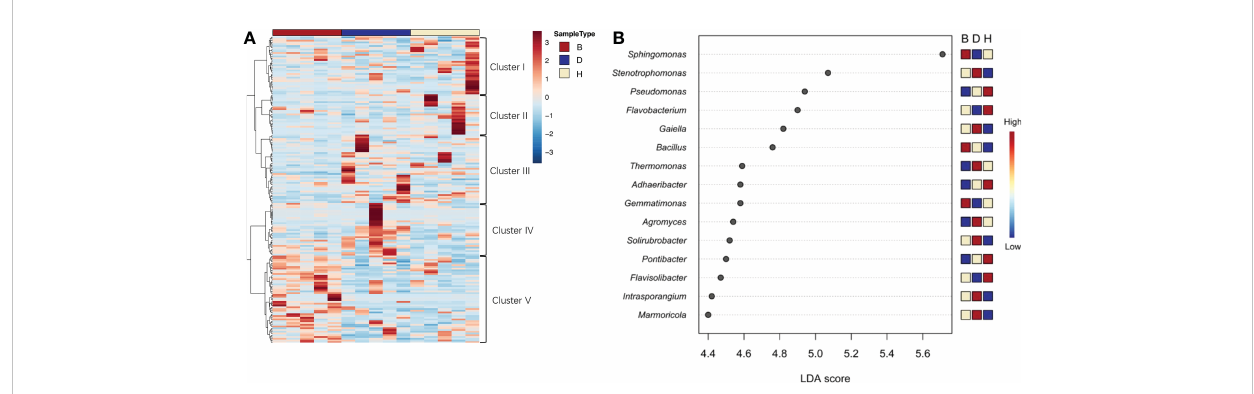
FIGURE 4 Differentially abundant bacterial genera in different soil groups. (A) Heatmap analysis showed group speci fi c prevalence of clusters. Distance measure was Euclidean and Ward clustering algorithm was used. (B) Graphical summary of LEfSe analysis. Signi fi cant taxa were ranked in decreasing order by their linear discriminant analysis (LDA) scores (x axis). The mini heat map on the right of the plot indicated whether the taxa were higher (red) or lower (blue) in each